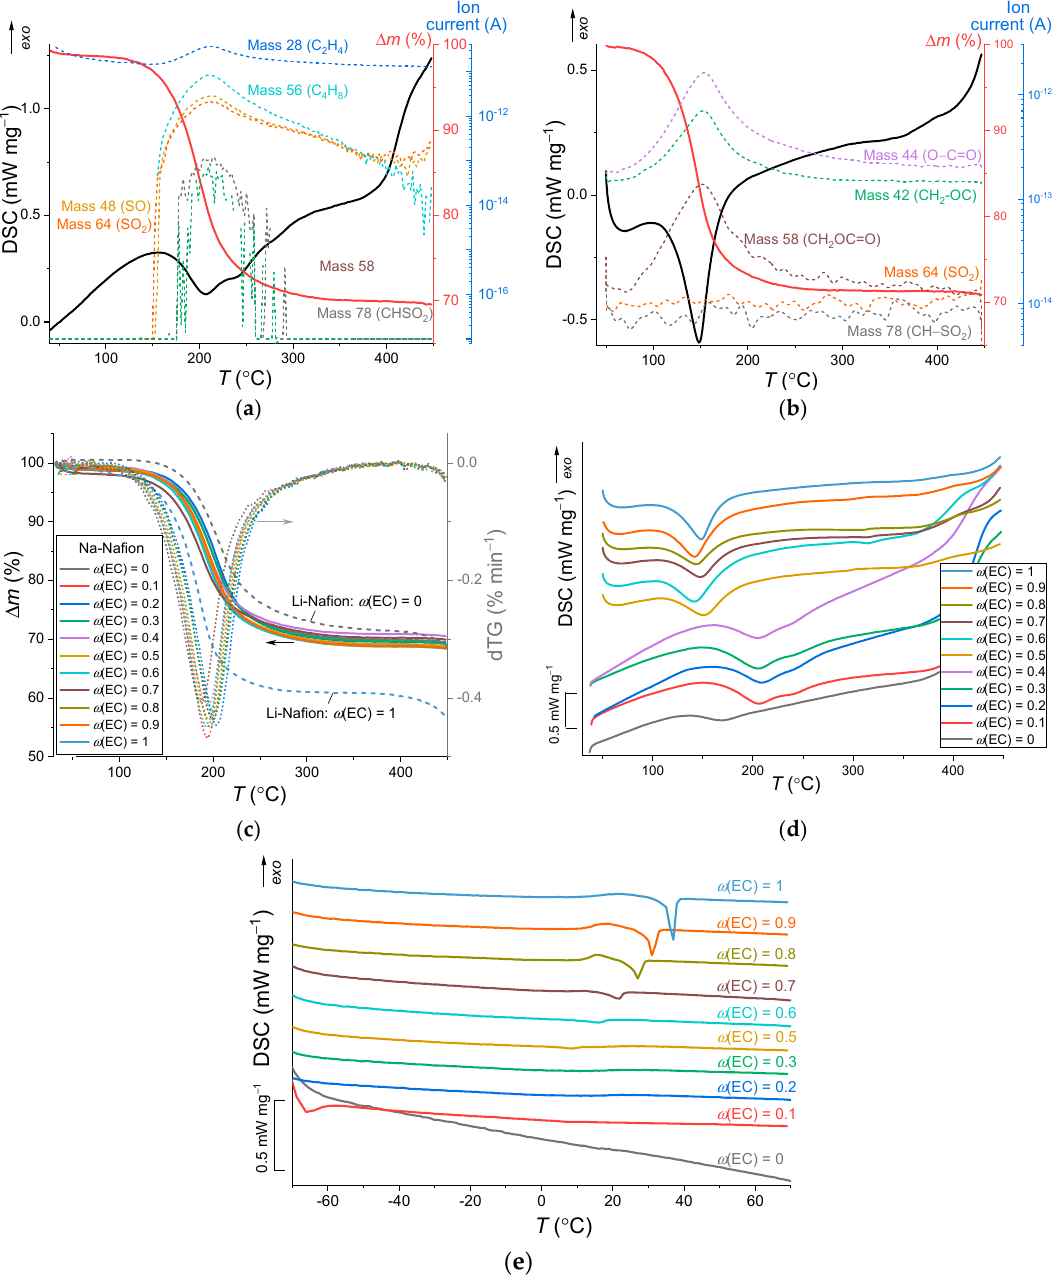
Figure 4. STA and ion current flow curves of the membrane swollen at 40 °C in ( a ) pure SL and ( b ) pure EC; ( c ) TGA curves (solid lines) and the first derivatives of the TGA curves (dotted lines) (for comparison, the TGA curves for the Li-Nafion are shown by dashed lines) and ( d ) DSC curves of the Na-Nafion membranes; ( e ) DSC curves in the low temperature region during heating. The absence of a current of ions with a mass of 48 and 64 for the sample with pure EC suggests that the entire weight loss is associated with the evaporation of the plasticizer from the membrane and not with its decomposition. The thermal decomposition of the polymer membrane was detected above 450 °C. The onset temperature of the thermal